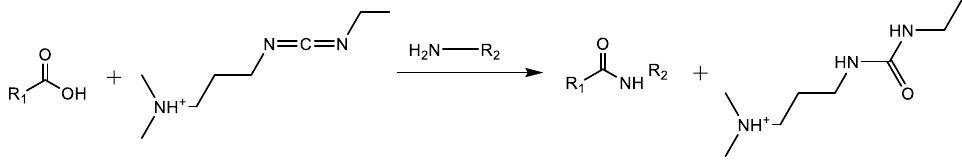
Figure 3. The general mechanism of carbodiimide chemistry.